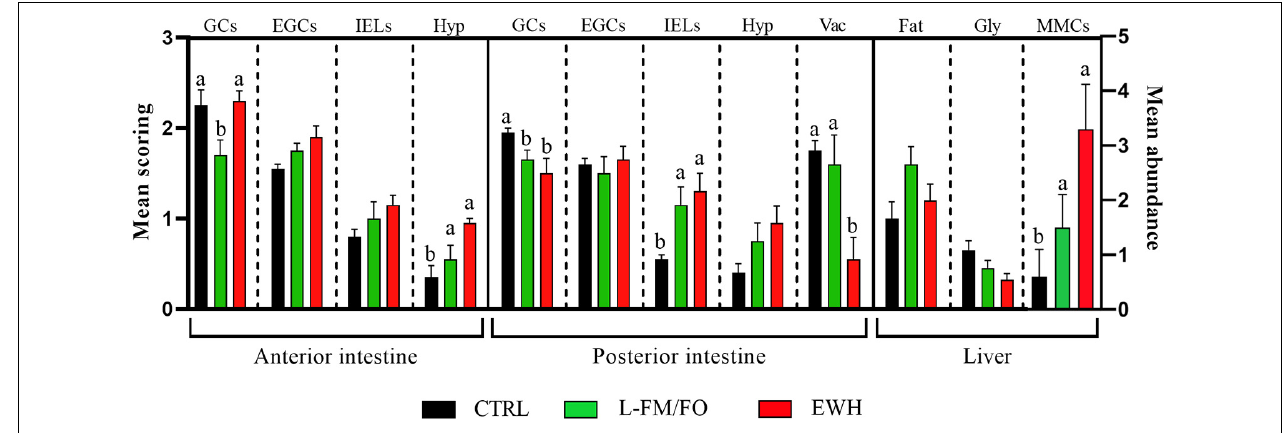
FIGURE 2 | Scoring of histological alterations in fish fed CTRL (black bars), L-FM/FO (green bars) and EWH (red bars) diets. Mean semiquantitative scoring (+SEM) from 0 (absence) to 3 (very abundant) is shown for presence of PAS+ goblet cells (GCs), eosinophilic granular cells (EGCs) and intraepithelial lymphocytes (IELs) in two intestinal segments. Mean semiquantitative scoring (+SEM) from 0 (absence) to 3 (severe) is shown for the degree of hyperplasia in the submucosa (Hyp), vacuolization of enterocytes (Vac) in two intestinal segments, and fat (Fat) and glycogen (Gly) storage in liver. Total melanomacrophage centers (MMCs) were quantified in liver (mean abundance, right y -axis, +SEM). Different letters within each alteration indicate statistically significant differences among diets ( P < 0.05).